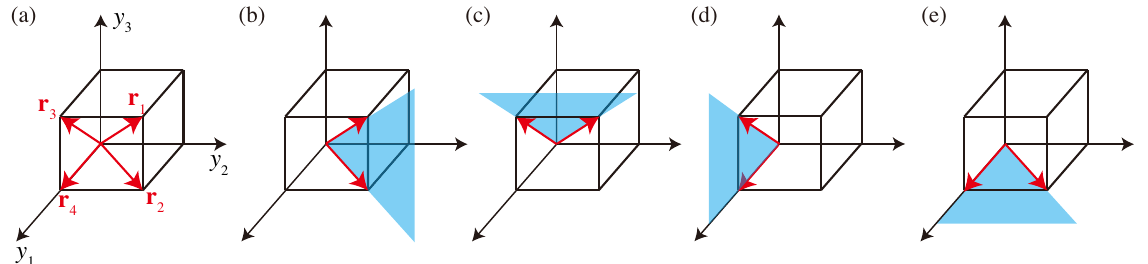
FIG. 6. The rays and boundary planes in the polyhedral cone Y in SG 150. (a) r 1 ¼ ð 1 ; 1 ; 1 Þ T , r 2 ¼ ð 1 ; 1 ; 0 Þ T , r 3 ¼ ð 1 ; 0 ; 1 Þ T , r 1 ; 0 ; 0 Þ T . (b) The y 4 ¼ ð